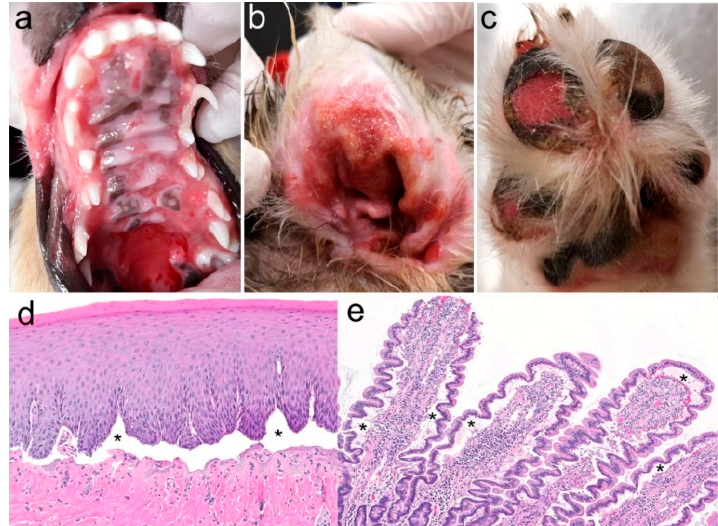
Figure 2 . Clinical and histopathological phenotype. ( a ) Severe coalescing ulcers on the gingiva and hard and soft palate, ( b ) concave pinna ( c ) and footpads. Biopsy samples collected from the ( d ) oral cavity and ( e ) duodenum revealed widespread separation of the epithelium from the underlying connective tissue (asterisks).